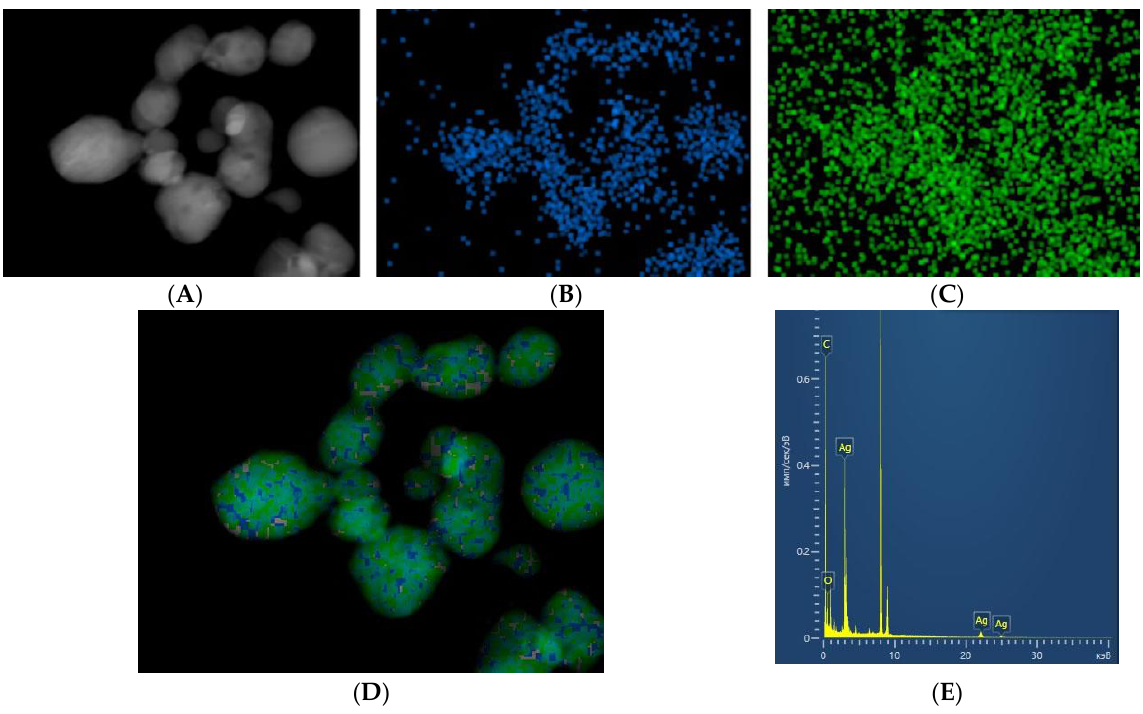
Figure 3. Elemental analysis of the resulting nanoparticles. ( A ) — TEM image of Ag 2 O nanoparticles. ( B ) — Visualization Ag K α 1. ( C ) — Visualization O K α 1. ( D ) — multilayer image (Ag K α 1 + O K α 1). ( E ) — Spectrum of the sample (X-axis — Energy, keV, Y-axis — Distribution, pulse/sec/eV).